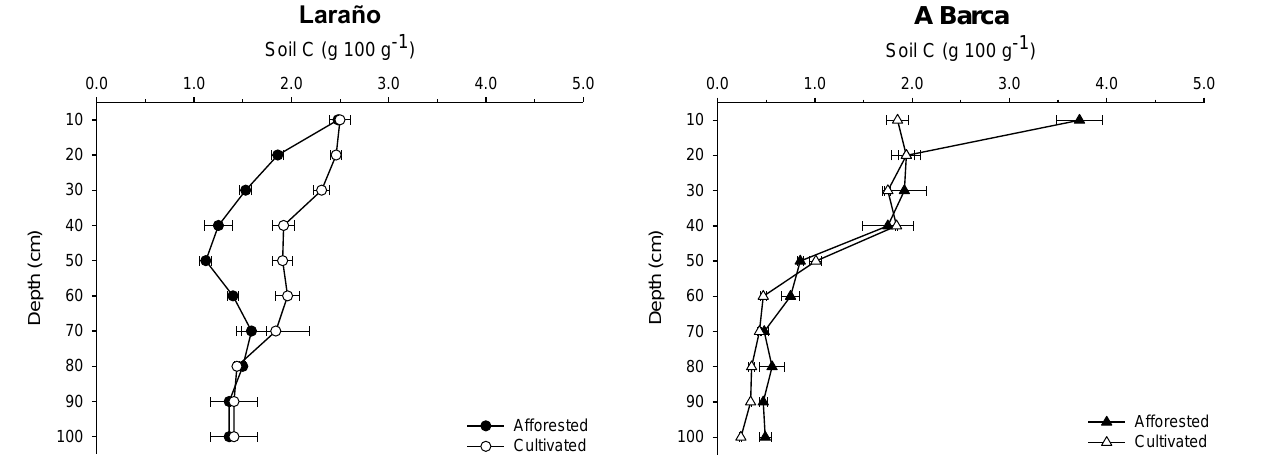
Figure 3. Depth-related distribution of the C concentration (g of C 100 g − 1 of soil, mean values ± standard deviation, n = 3) in the soils under study.